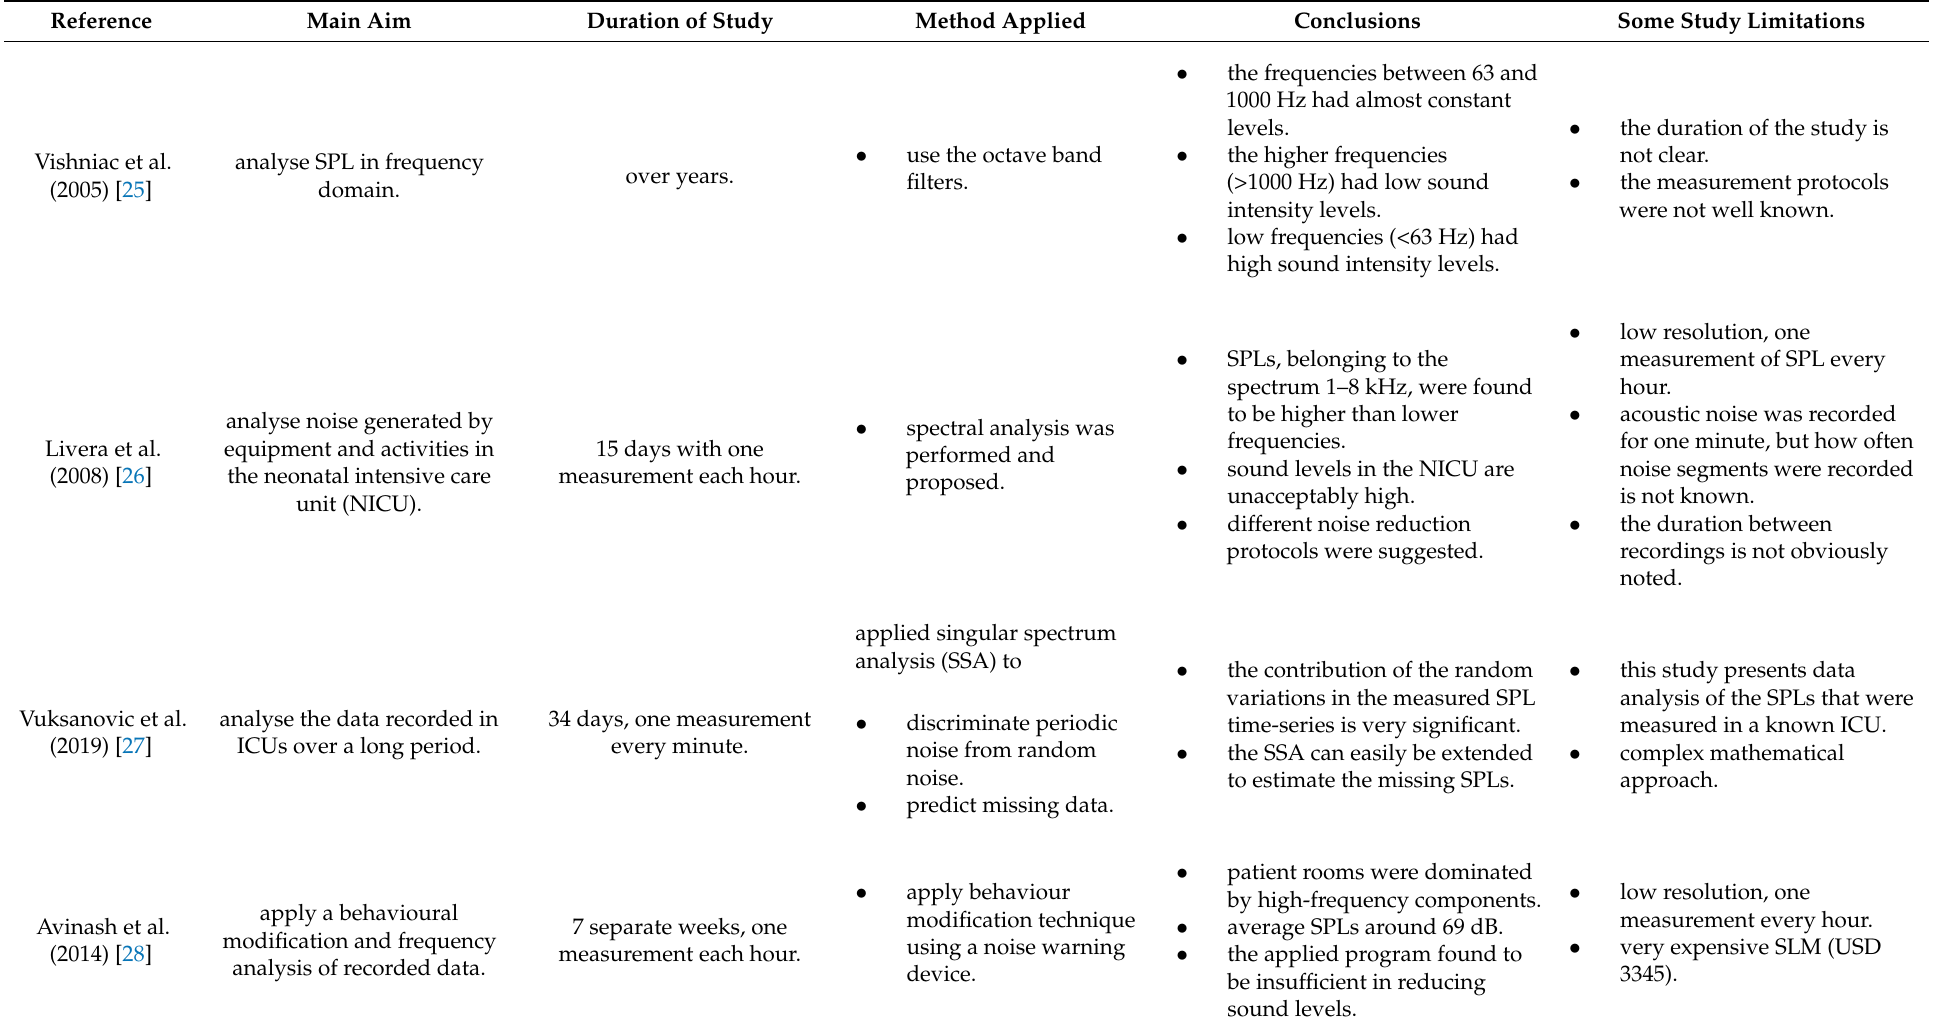
Table 3. Summary of the studies applied frequency